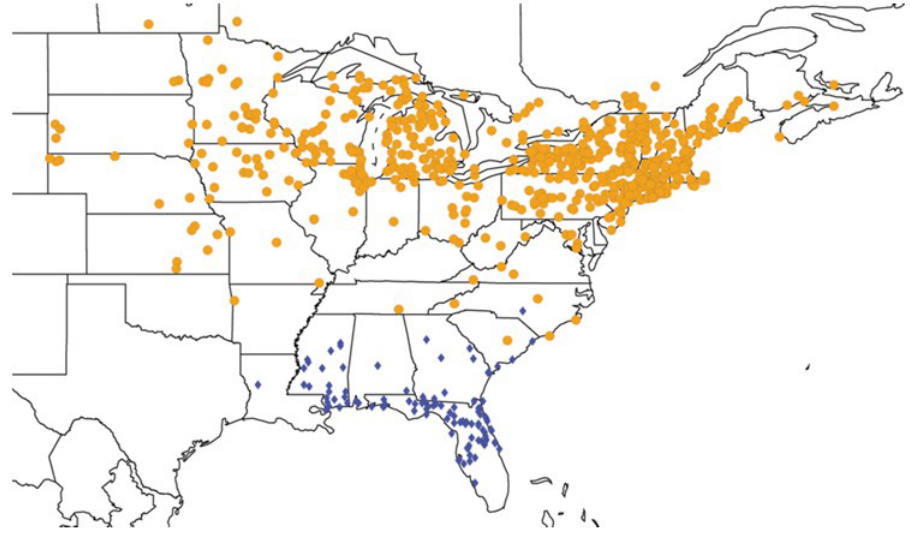
Figure 15. Distribution of Tibicen canicularis (gold circles) and T. similaris (blue diamonds).